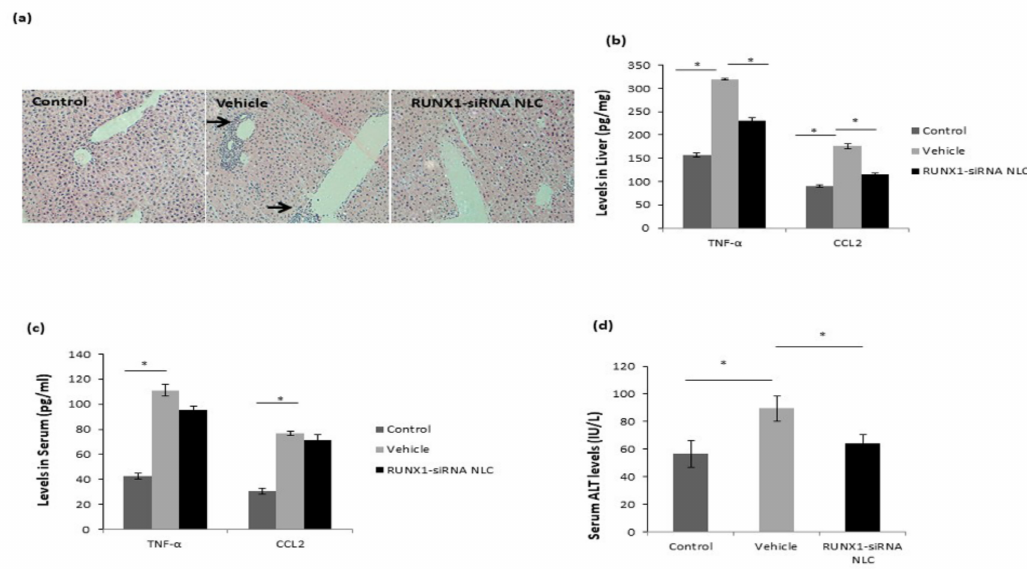
Figure 7. RUNX1 siRNA mice show reduced liver inflammation. ( a ) H&E (10 × ) and CD45 (20 × ) immunohistochemistry of liver sections showing inflammatory cells (arrows) in the lobular and portal areas of liver in vehicle and RUNX1 siRNA NLC mice. ( b ) Levels of TNF- α and CCl2 (pg/mg protein) in liver tissue homogenates of control, vehicle, and RUNX1 siRNA NLC mice. Standard curve was drawn using standards provided in the kit, and each analyte concentration was calculated from the standard curve. The assays were normalized to 1 mg liver protein. ( c ) Levels of TNF- α and CCl2 (pg/mL) in serum samples of control, vehicle, and RUNX1 siRNA NLC mice. ( d ) Serum ALT Levels (IU/L) in control, vehicle, and RUNX1 siRNA NLC mice. Data represented as mean ± SD, n = 4. * p <